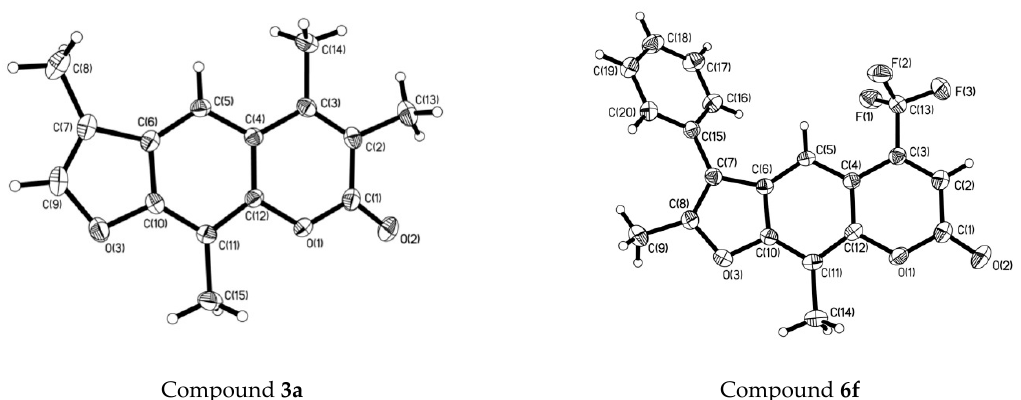
Figure 2. X-ray single crystal structures of compounds 3a and 6f .